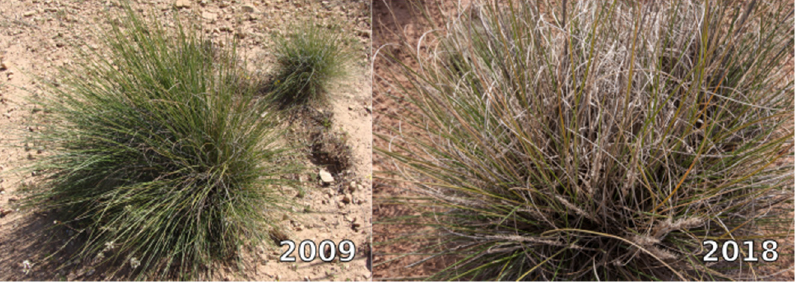
Figure 8. Comparison of greenness between Stipa tenacissima plants from 2009 and 2018 from sites located in close vicinity.